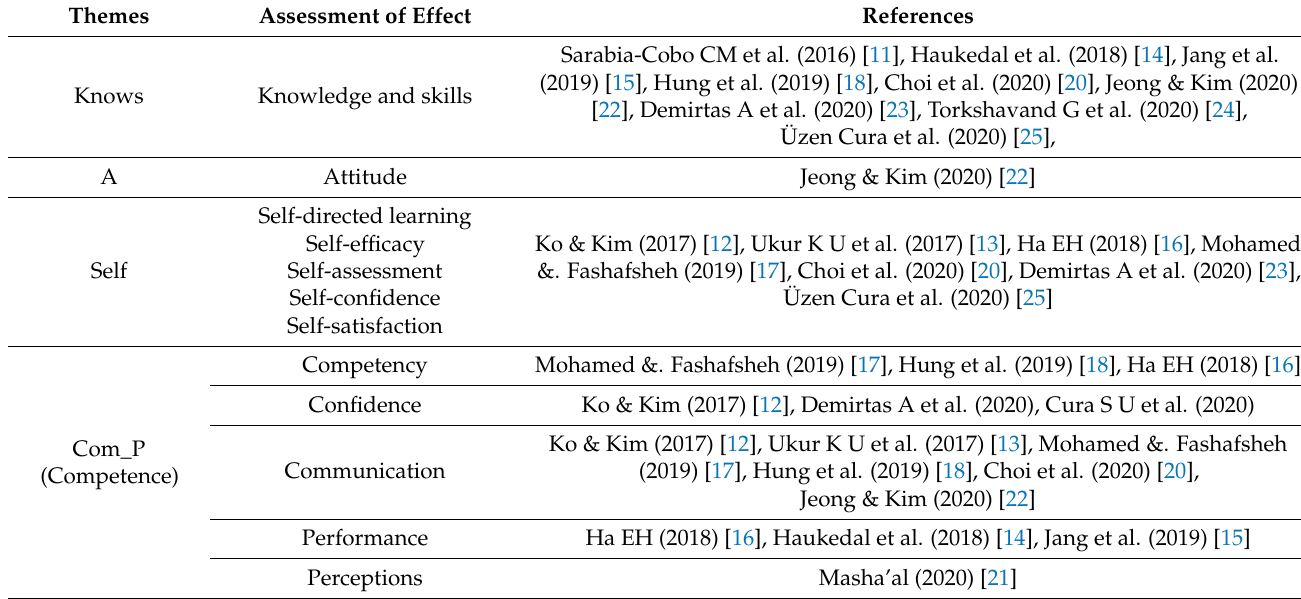
Table 2. Themes of simulation-based learning (SBL) in nursing